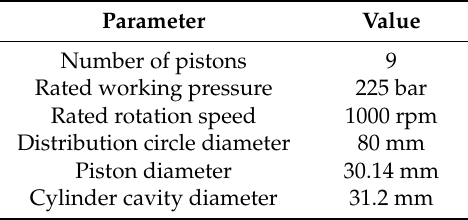
Table 1. Structure and working parameters.